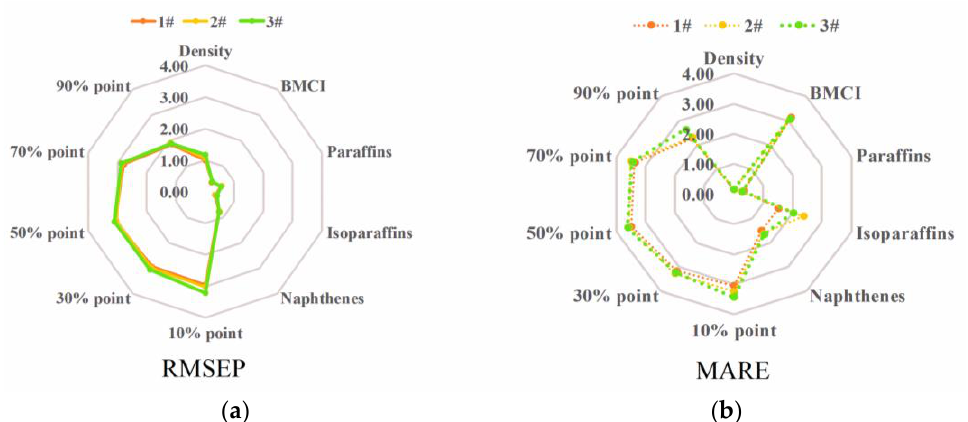
Figure 9. Online prediction accuracy of HBO samples in three run periods. ( a ) RMSEP of density, BMCI , paraffins, isoparaffins, naphthenes, 10% point, 30% point, 50% point, 70% point, and 90% point. ( b ) MARE of 10% point, 30% point, 50% point, 70% point, and 90% point.